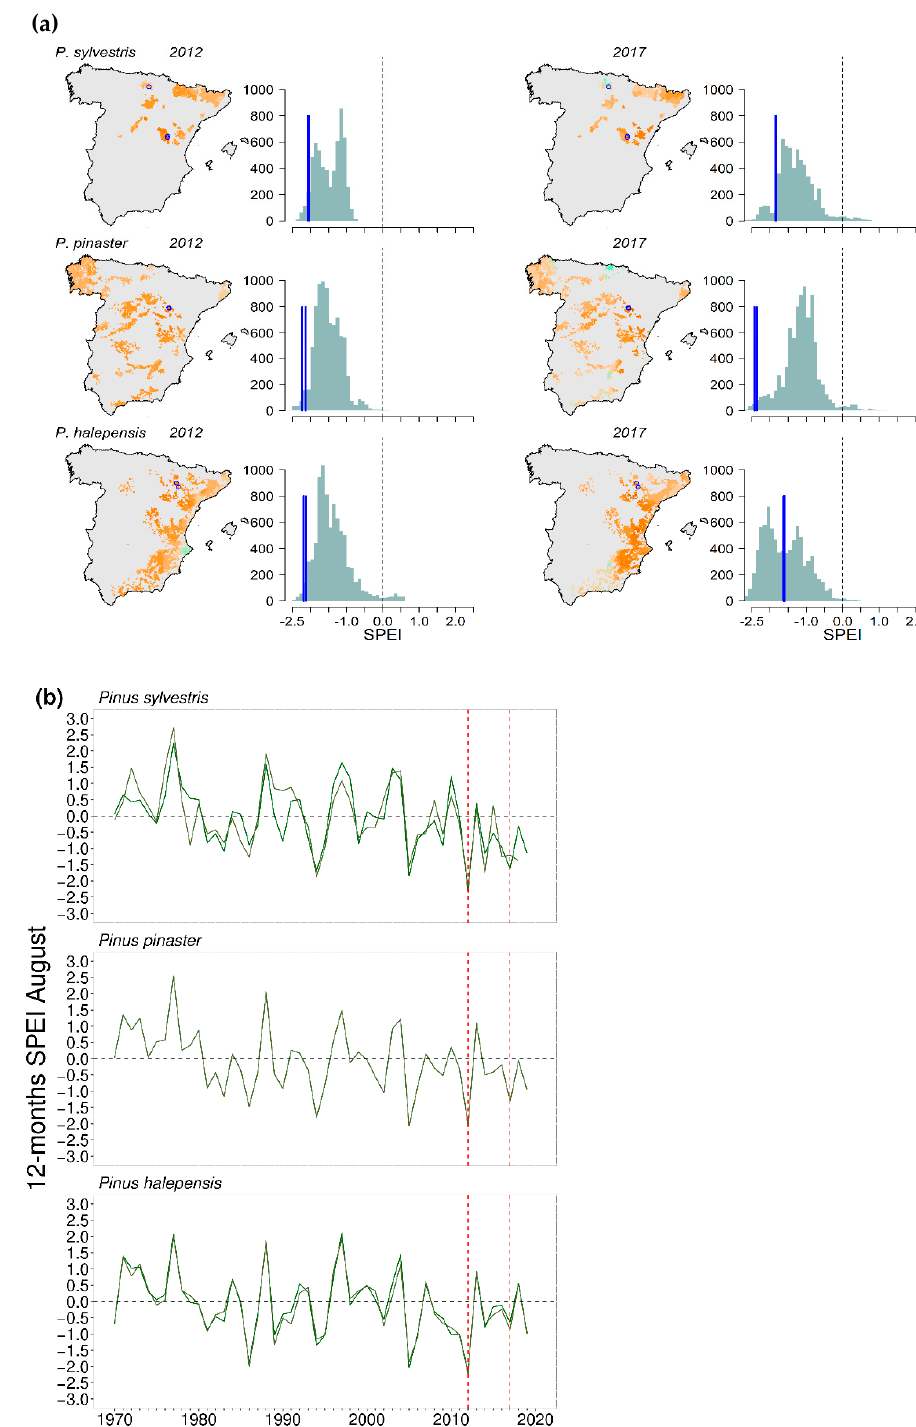
Figure 1. Spatial ( a ) and temporal ( b ) patterns of drought severity based on 12-month SPEI August values. The histograms ( a ) show the distribution of SPEI values for the 2012 and 2017 droughts as compared with SPEI values of the whole distribution area of the three study pine species in Spain (maps with orange patches and symbols showing sites’ locations). The lower plot ( b ) shows the mean SPEI values for each species considering the period 1970–2019 (in the case of P. sylvestris and P. halepensis two curves are presented corresponding to two 1.1-km 2 grids). The vertical dashed lines indicate the 2012 and 2017 droughts.